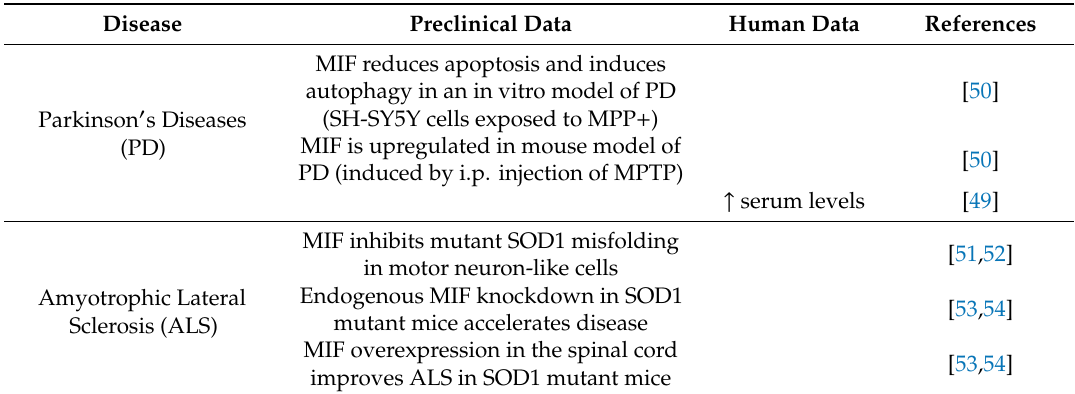
Table 1. Evidences for the involvement of the Macrophage Migration Inhibitory Factor (MIF) in neurodegenerative